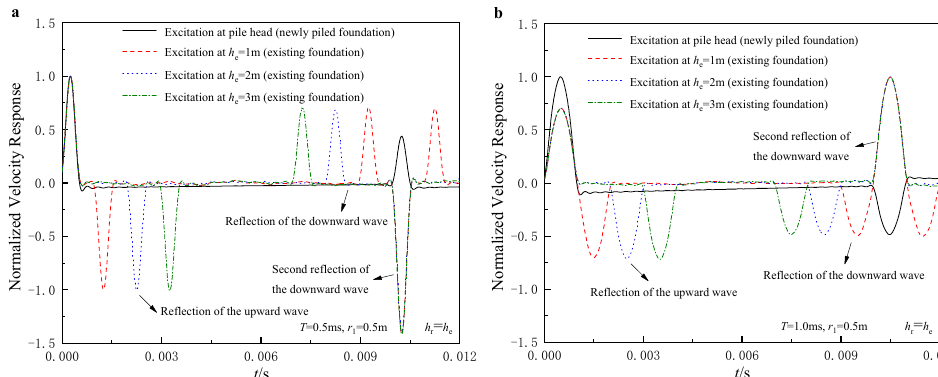
Figure 2. Comparisons of velocity response between existing and newly piled foundations: ( a ) vis- coelastic boundary at the pile end ( T = 0.5 ms); ( b ) fixed boundary at the pile end ( T = 1.0 ms).